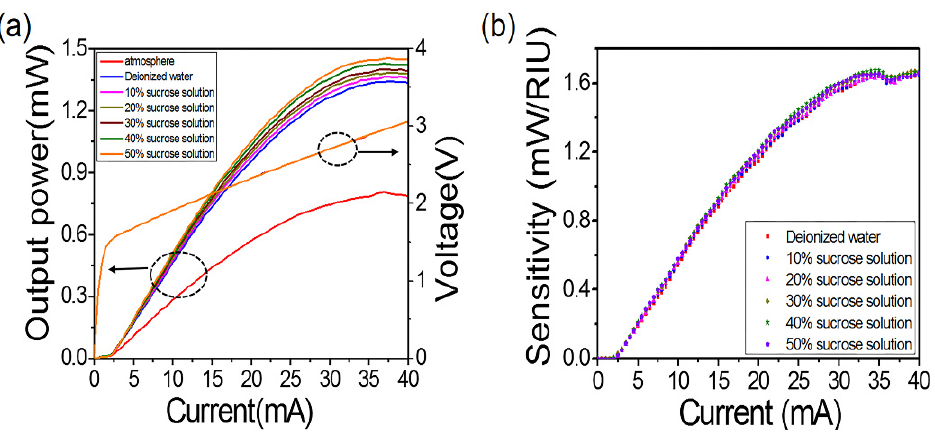
Figure 3. ( a ) P-I-V characteristics of sensor under different conditions. ( b ) Sensitivity curve of sensor and air environment. and air